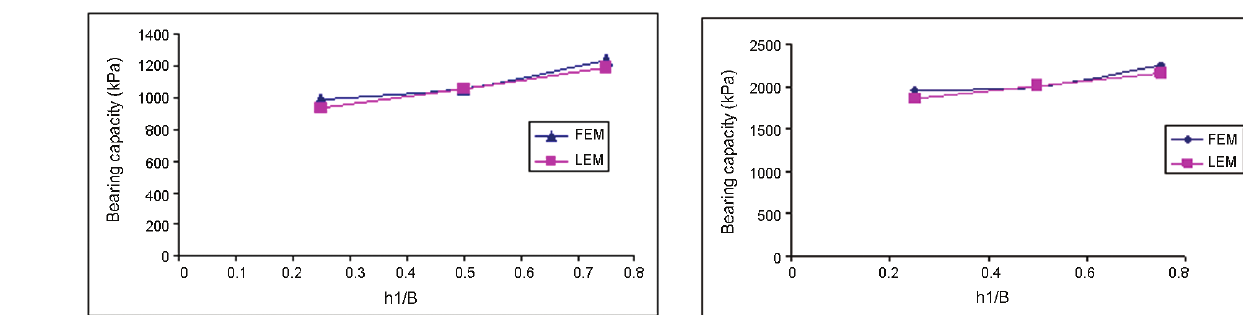
Fig. 5. Comparison of bearing capacity values with models (B = 2 m, L = B and ϕ 1 = 39° on ϕ 2 =